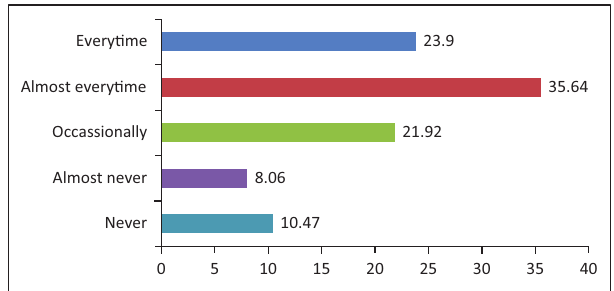
FIGURE 4: Compliance with the administrative reporting provisions of tasks.